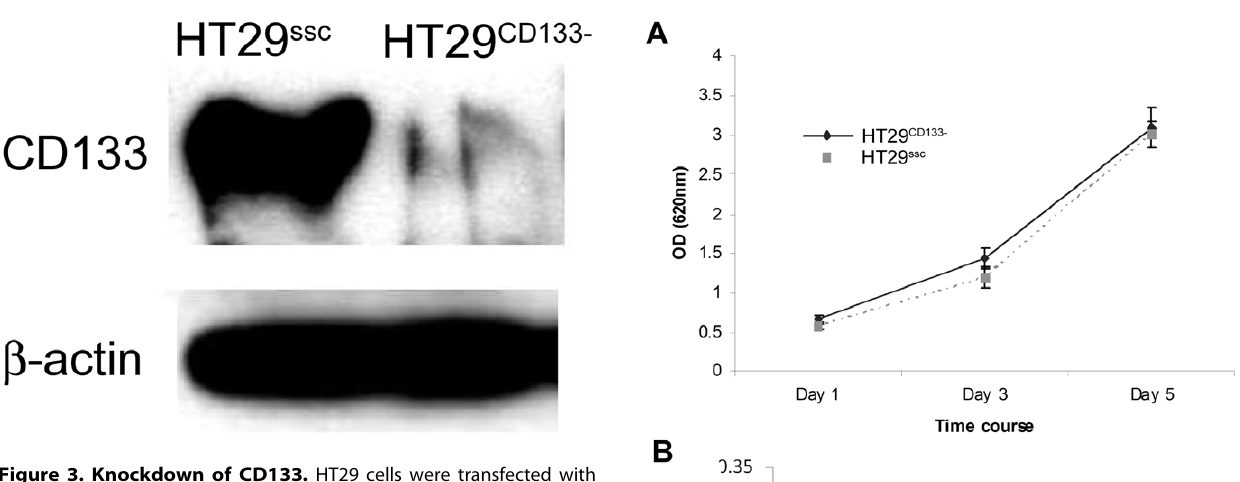
Figure 3. Knockdown of CD133. HT29 cells were transfected with either CD133 specific siRNA (HT29 CD133 2 ) or scrambled control ((HT29 ssc ). Western blotting confirmed the loss of CD133 expression by gene knockdown. b -Actin shows equal protein loading.